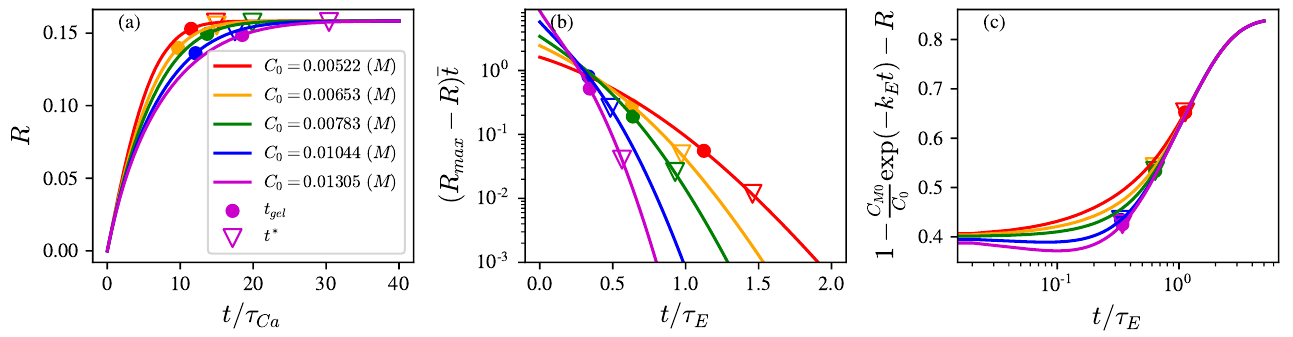
Figure 2. ( a ) The binding ratio R solved via Equation (16) versus the dimensionless time t / τ Ca , with R max = 0.158, and D = 0.4. t gel and t ∗ are represented by circles and triangles, re- spectively. ( b ) ( R max − R ) ¯ t represents the dimensionless characteristic consumption rate con- stant. ( c ) [ 1 − ( C M 0 / C 0 ) exp ( − k E t ) − R ] represents the portion of active but unbound sites. With − 1 = τ Ca ≡ ( k 1 C 2 γ ) 980, 650, 460, 280, and 190 s for GA concentrations ( C 0 ) 5.22 (red), 6.53 (orange), 0 7.83 (green), 10.44 (blue), and 13.05 (purple) mM, respectively. t gel is marked by circles, and t ∗ is marked by